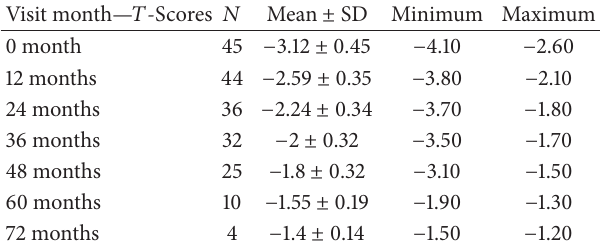
Table 3: 𝑇 -scores over 72 months of testosterone treatment.